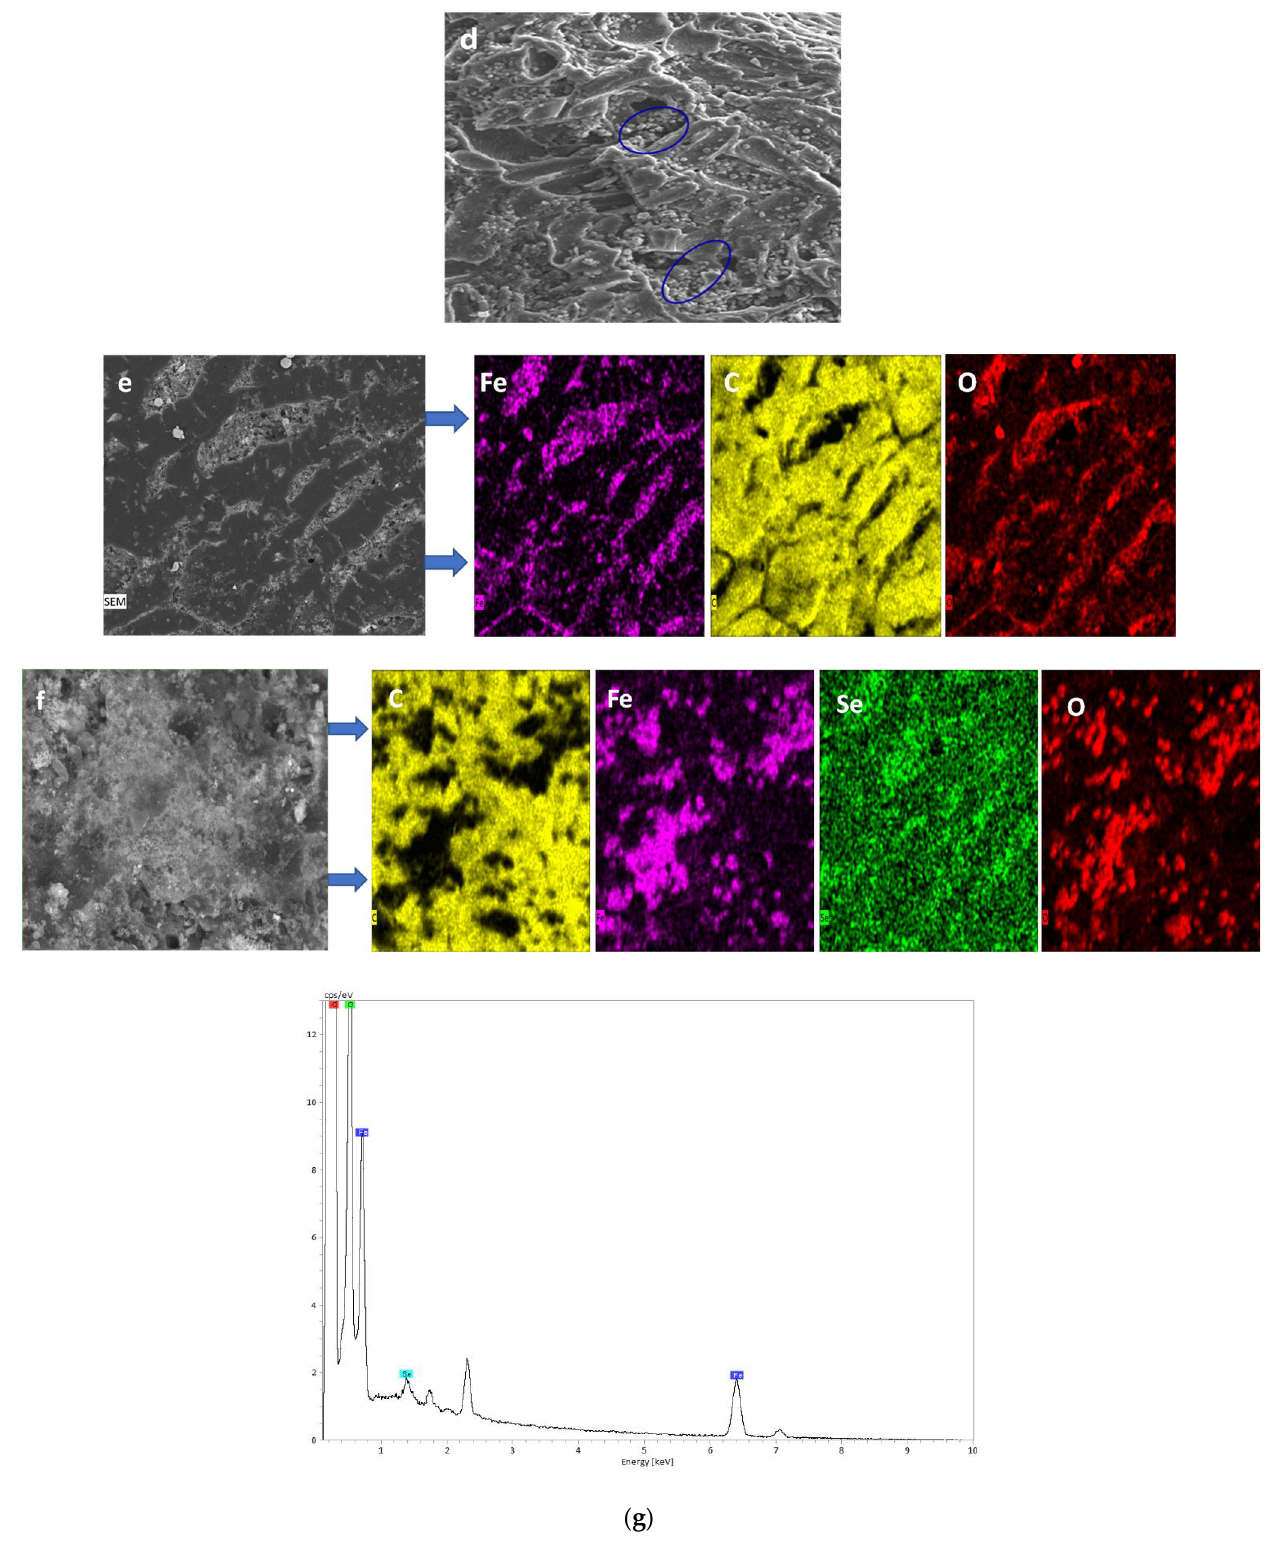
Figure 1. SEM images: ( a ) activated carbon, ( b ) non-supported nZVI, ( c ) nZVI/GAC composite, ( d ) nZVI/GAC post-adsorption. SEM images of energy-dispersive spectrum of nZVI/GAC: ( e ) pre-adsorption and ( f ) post-adsorption. ( g ) Energy-dispersive spectrum distribution plot of nZVI/GAC showing post-removal elemental composition (C, O, Fe and Se).